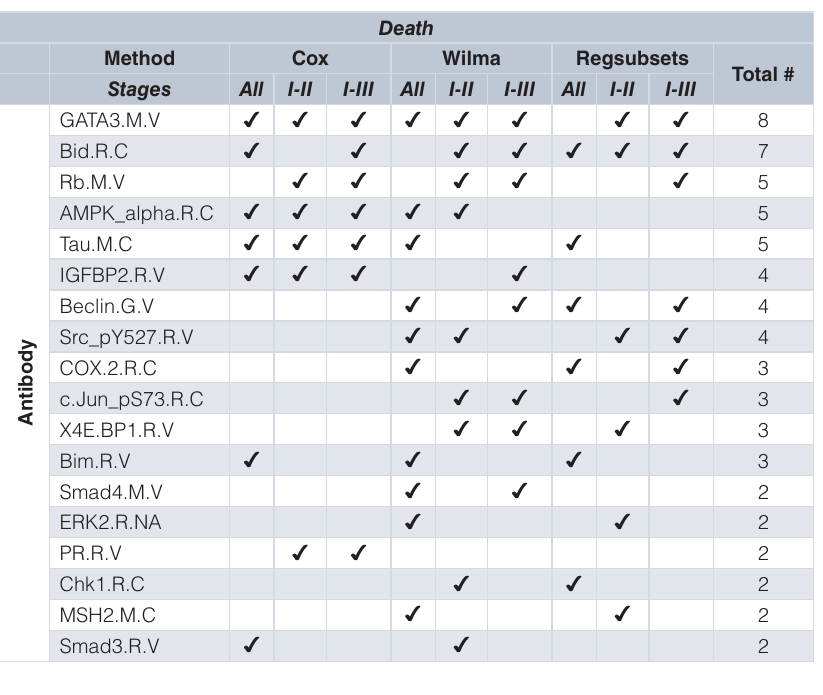
Table 3. Summary tables for death, ordered by the number of times each protein was selected. Proteins that were identified by more than one computational method (Cox regression, Wilma, or Regsubsets) were included. Proteins identified by Cox regression and the Wilma algorithm were significantly associated with prognosis (p<0.05); proteins are included for Regsubsets if they were identified five times or more.